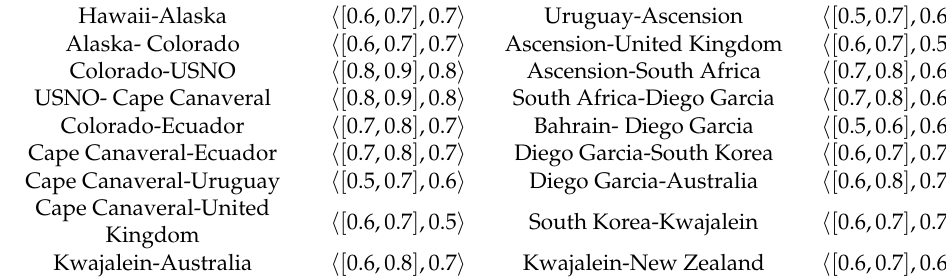
Table 3. Cubic membership values among monitoring